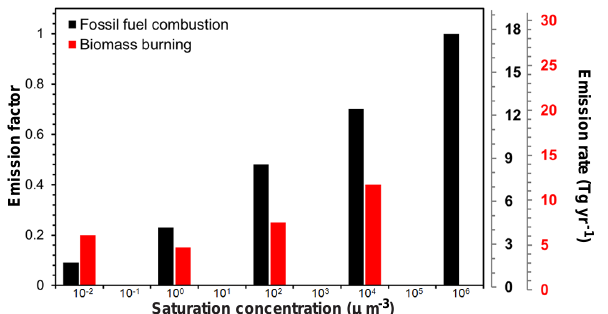
Figure 2. Volatility distribution for fuel combustion (in black) and biomass burning (in red) organic emissions. The emission fac- tors for fuel combustion emissions are derived from Robinson et al. (2007) while for biomass burning POA emissions are from May et al. (2013) (shown in the primary y axis). The corresponding emis- sion rates are also shown in the secondary y axis.